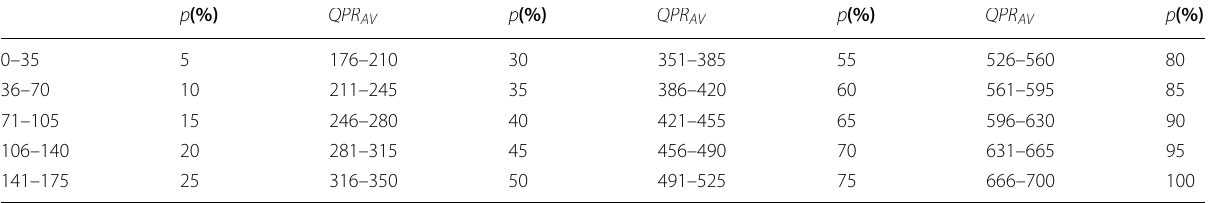
Table 1 Penetration rate fractiles